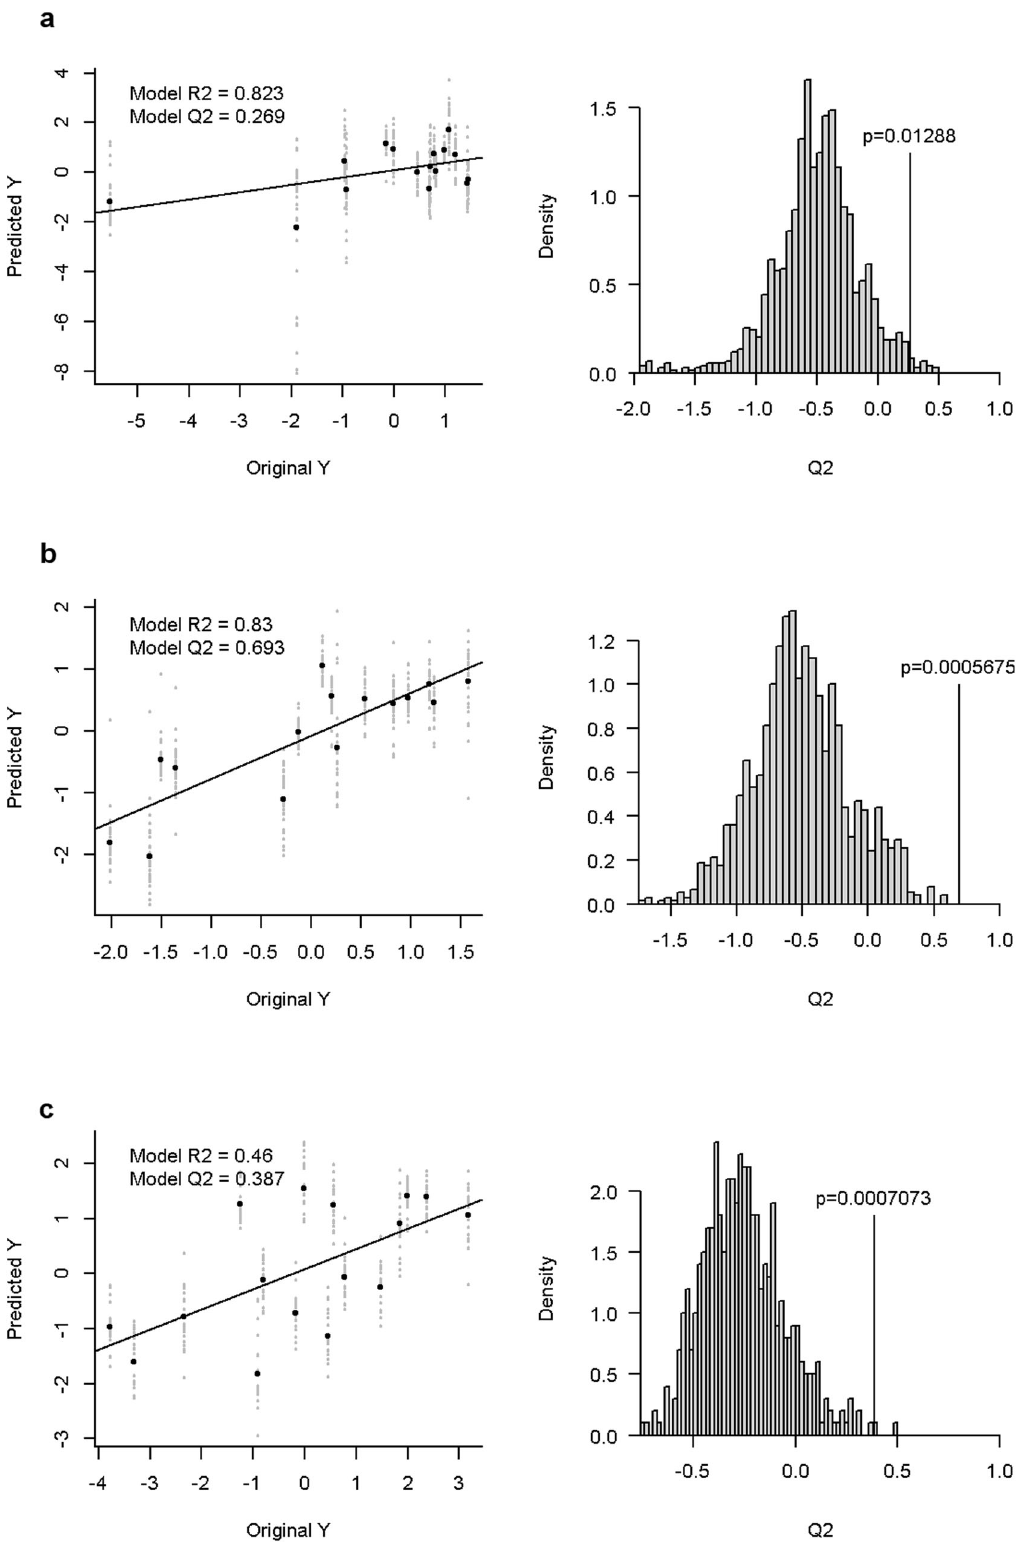
Fig. 1 Partial least square (PLS) regression plots of actual and predicted. a sperm quality ( n = 16), b sperm function ( n = 15) and ( c ) in vitro fertilisation outcomes ( n = 16). Reduced-dimension feature vectors from projection are shown in the left, and permutation tests based on the prediction capability are depicted on the right. In the x-axis, PLS regression plots show original centred, reduced-dimension feature vectors from each principal component analysis. The values predicted by the models are displayed on the y axis. The slope is de fi ned by the prediction capability values (Q2) tested through permutation tests. The vertical lines of permutation test plots indicate the Q2 values obtained in each